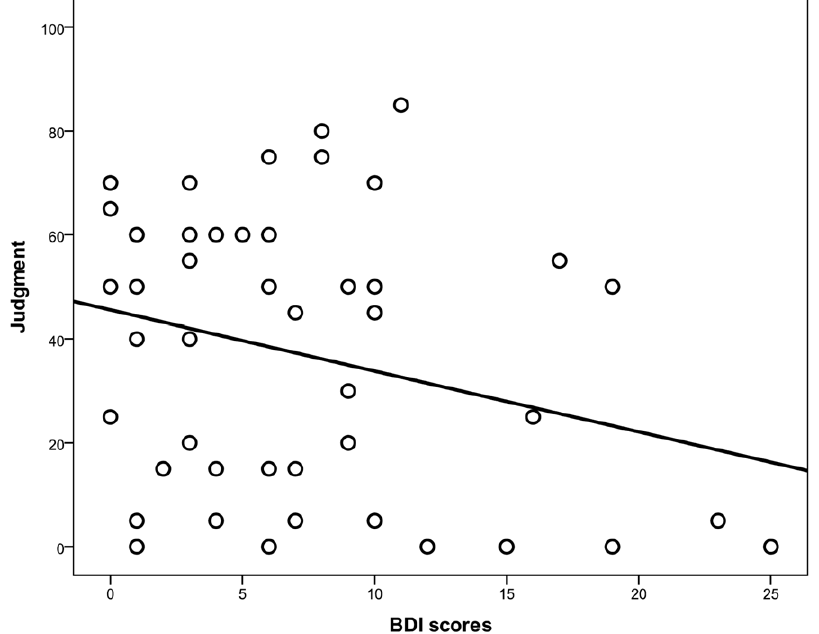
Figure 2. Scatterplot depicting the judgments as a function of BDI scores in Study 1. The scatterplot shows the judgments of control (vertical axis) as a function of the direct BDI scores (horizontal axis). The line fitting the data points displays a negative slope, indicating that the participants with higher BDI scores were more accurate in their judgments, thus replicating the depressive realism effect.